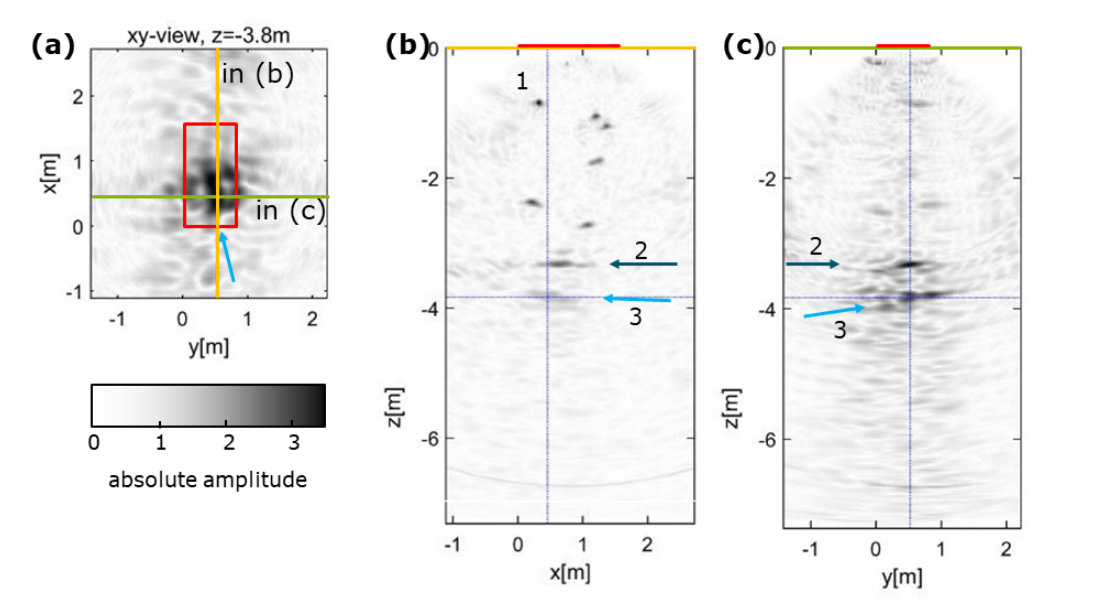
Figure 4. LAUS ultrasonic imaging results at area 2 at large scale shotcrete construction. ( a ) xy–slice at a depth of z = − 3.8 m with measurement area (red) and corresponding slices marked. ( b ) yz–slice and ( c )